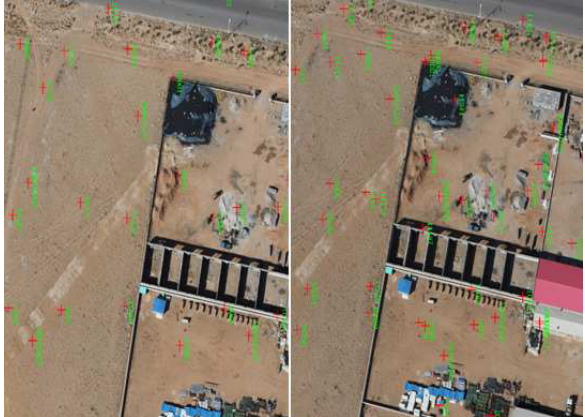
Figure 1. The distribution of corresponding points of the stereo pair at the beginning of a strip in the first